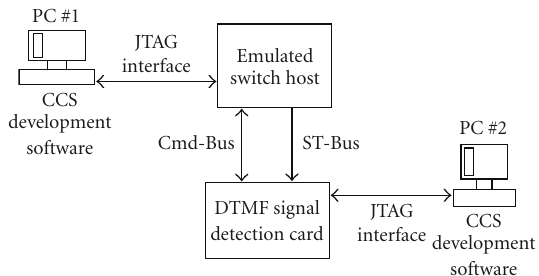
Figure 8: Screenshot of the Multifunctional Automatic Pulse Wave Analyzer [16,